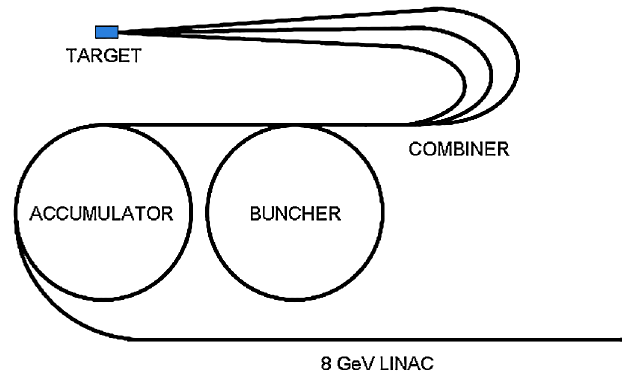
FIG. 3. (Color) Proton rebunching scheme. Accumulator and buncher rings form intense short proton bunches. The combiner is used to adjust the spacing between bunches, if